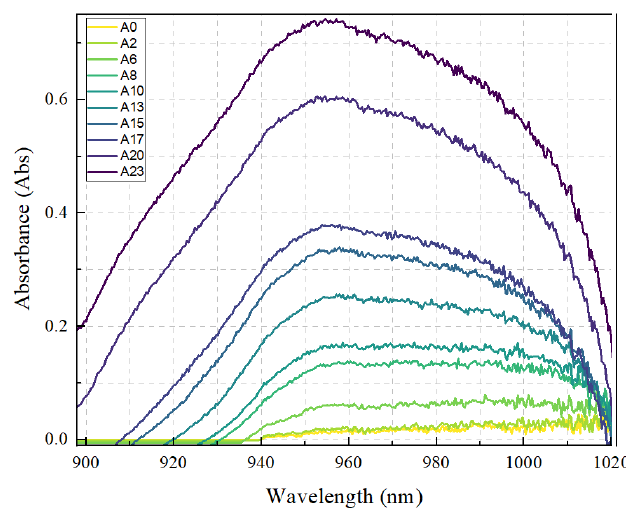
Figure 1. Optical absorbance of NS6 in the NIR region. The labels (A0, A1, A2, etc.) represent the days of the measurement since the start of growth. It is well established that green microalgae undergo photosynthesis to produce glu- cose [40,41], which is then converted into other carbohydrate components such as